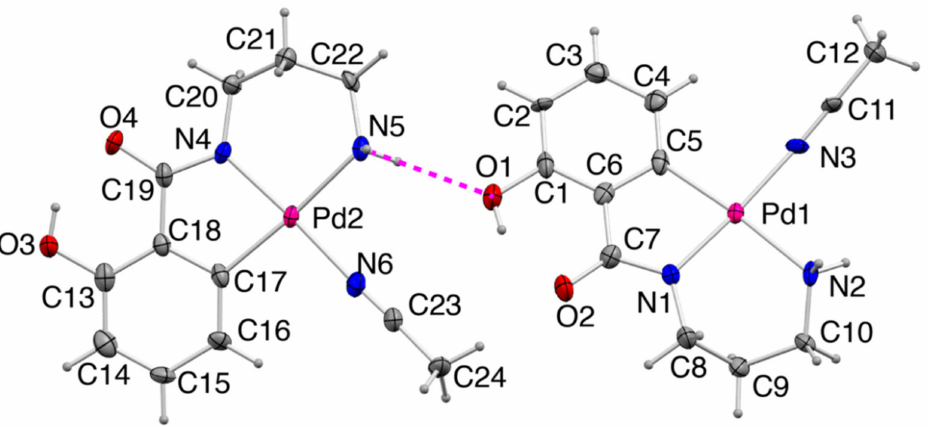
Figure 4. The asymmetric unit of 2 (50% probability levels). An intermolecular hydrogen bond is shown as magenta dashed